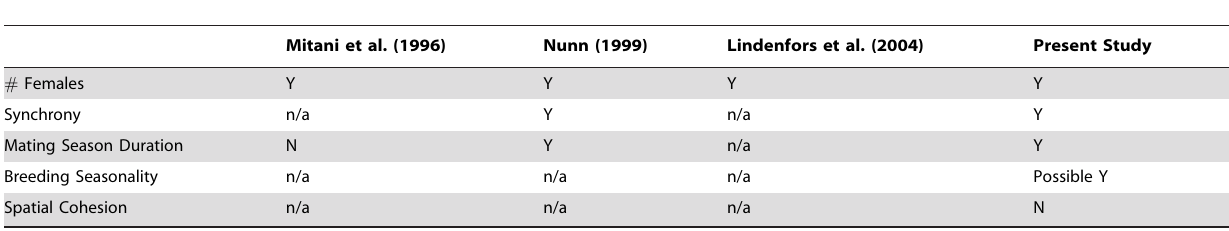
Table 3. Summary of significant results and comparison with significant results of similar